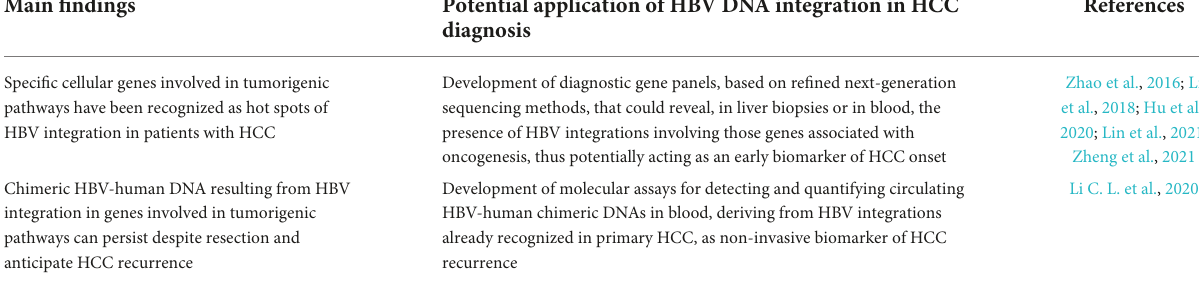
TABLE 2 Current knowledge on HBV integration in blood